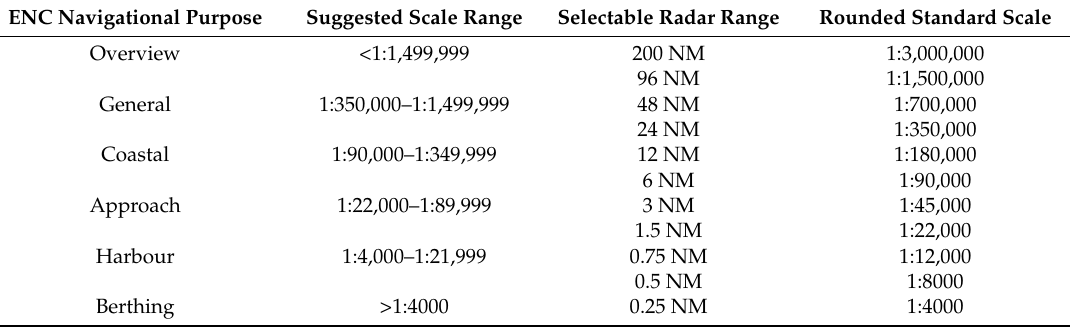
Figure 1. Graphical representation of the chain-node topological model enforced by the S-57 ENC specifications. A geospatial feature may be represented as a point (by an isolated node), a line (using a series of edges and connected nodes), or an area (by a closing loop of edges starting and ending at a common connected node). Vector objects may be shared, but duplication of coincident linear geometry is prohibited [32]. Table 1. The Electronic Navigational Chart (ENC) navigational purposes with range of compilation scales (and the standard radar scale within each range) suggested by the International Hydrographic Organization(IHO) S-65 publication [31].